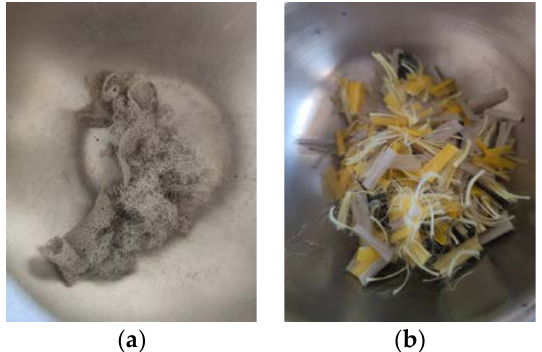
Figure 3. Stabilizing agents of TAO mixes: ( a) cellulose fibres; ( b) synthetic fibres.